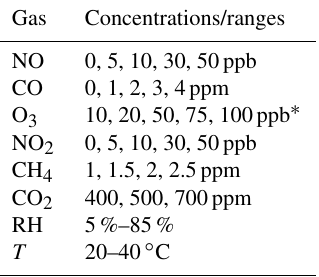
Table 2. Lab calibration procedure and environmental condition ranges for gases. Each non-zero gas concentration is maintained for